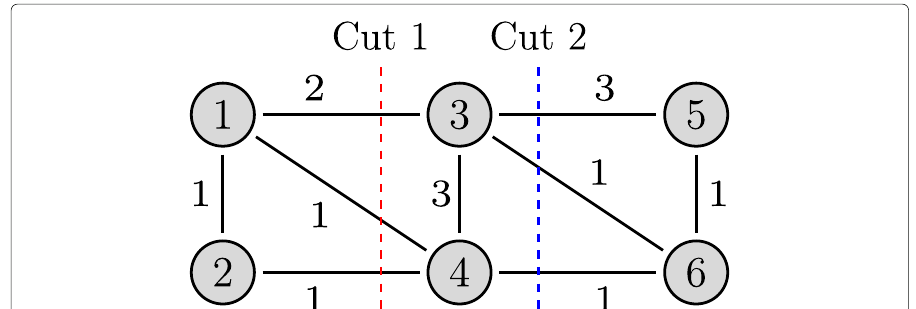
Fig. 2 An example illustrating that different weighting schemes prefer different motif cuts: the four triangles and 5 , and product-weights of 6, 1, 3 and 3 respectively whereas the minimum have mean-weights of 2, 1, 5 3 3 edge weight in each triangle is 1. Thus, the minimum formulation cannot distinguish between the cuts, whereas, under the mean formulation Cut 1 gives a cut of size 9, and Cut 2 gives a cut of size 10. On the other hand, under the product formulation, Cut 1 gives a cut of size 7, and Cut 2 gives a cut of size 6. Hence the mean formulation prefers Cut 1 and product formulation prefers Cut